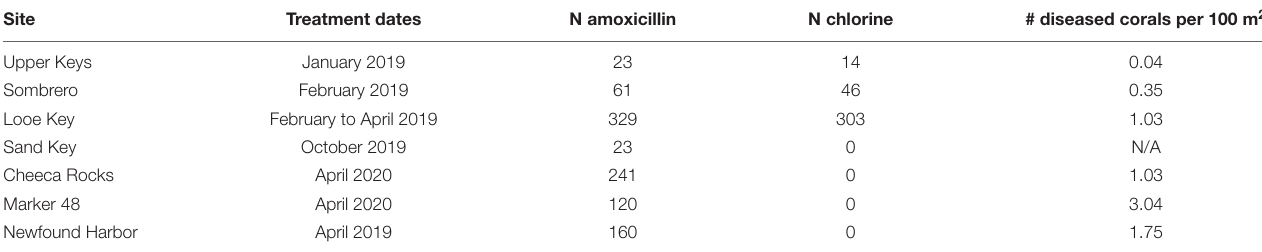
TABLE 1 | Dates and number of corals (N) treated with amoxicillin paste and chlorinated epoxy treatments during the initial visits to each site.